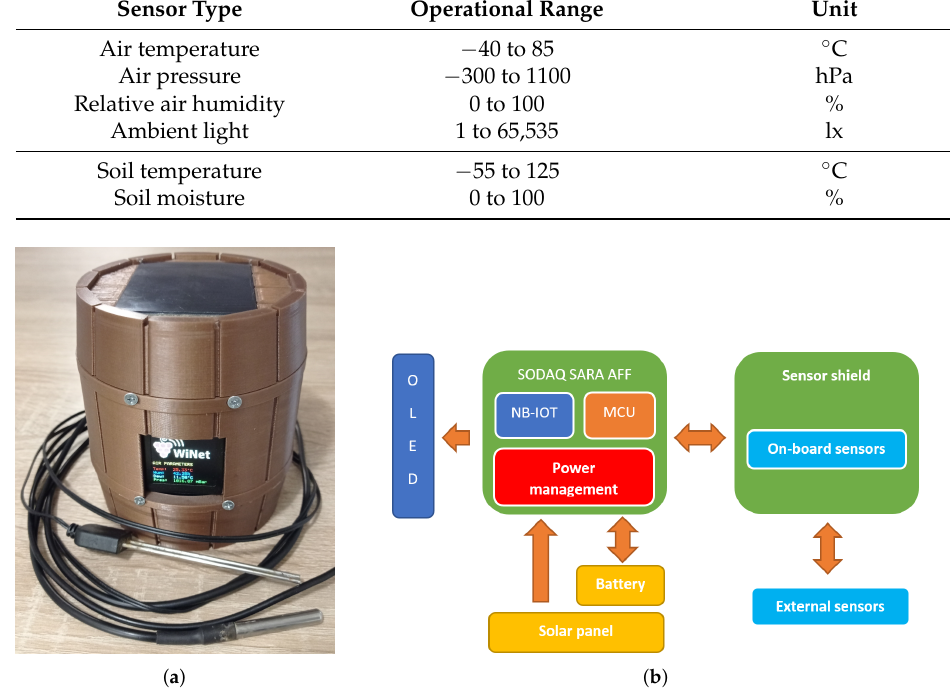
Figure 5. Sensor device: ( a ) physical appearance; and ( b ) block